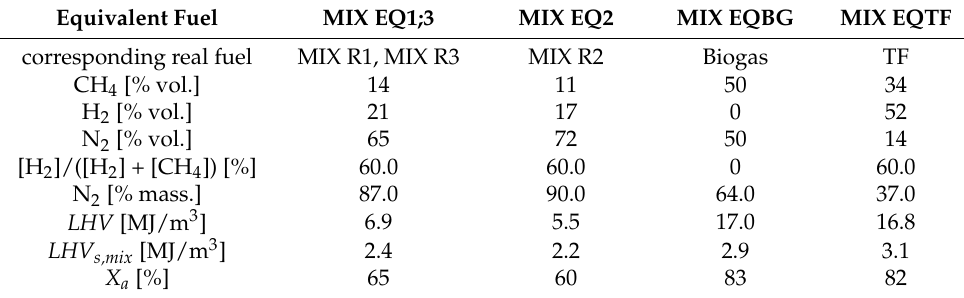
Table 3. Equivalent mixtures (properties at 15 ◦ C and 1 bar).